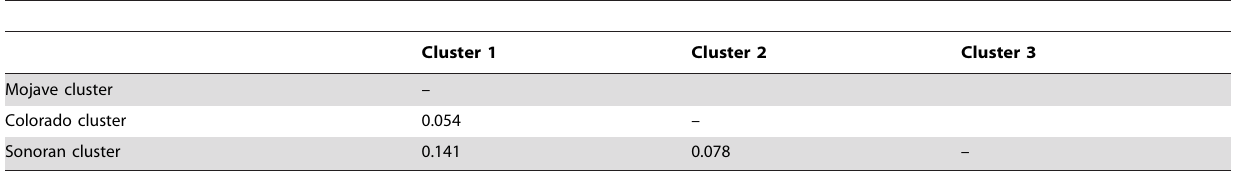
among clusters of Chionactis occipitalis identified by STRUCTURE , all estimates were significant after Bonferroni Table 4. Pairwise F ST correction.